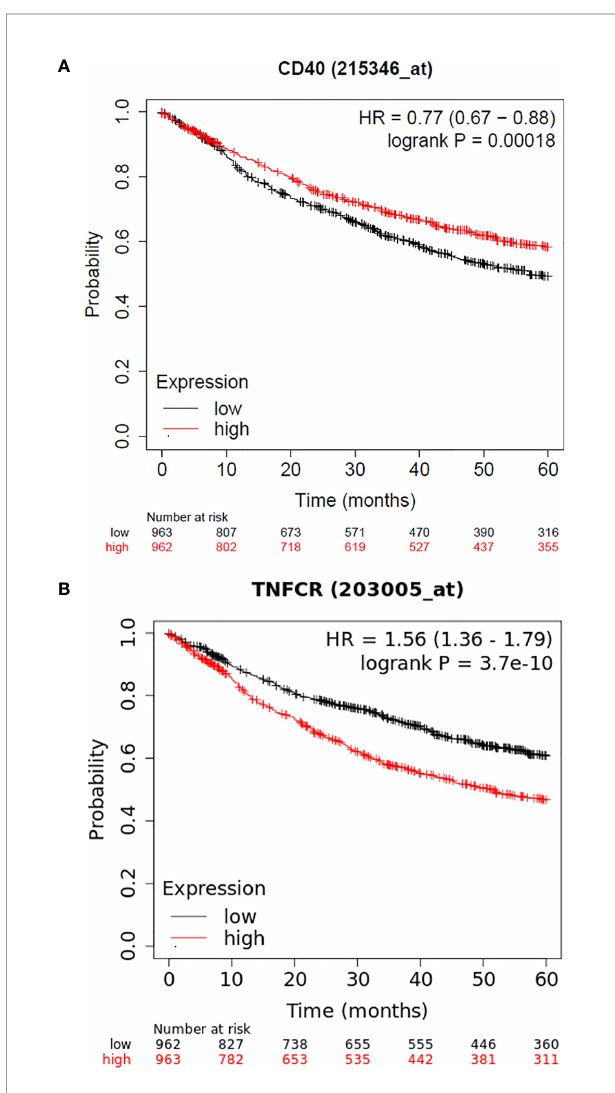
FIGURE 2 | (A) Kaplan – Meier curves depicting 5-year OS of NSCLC patients in relation to CD40 mRNA levels as provided by KM plotter, (B) Kaplan – Meier curves depicting 5-year OS of NSCLC patients in relation to LT b R mRNA levels as provided by the KM